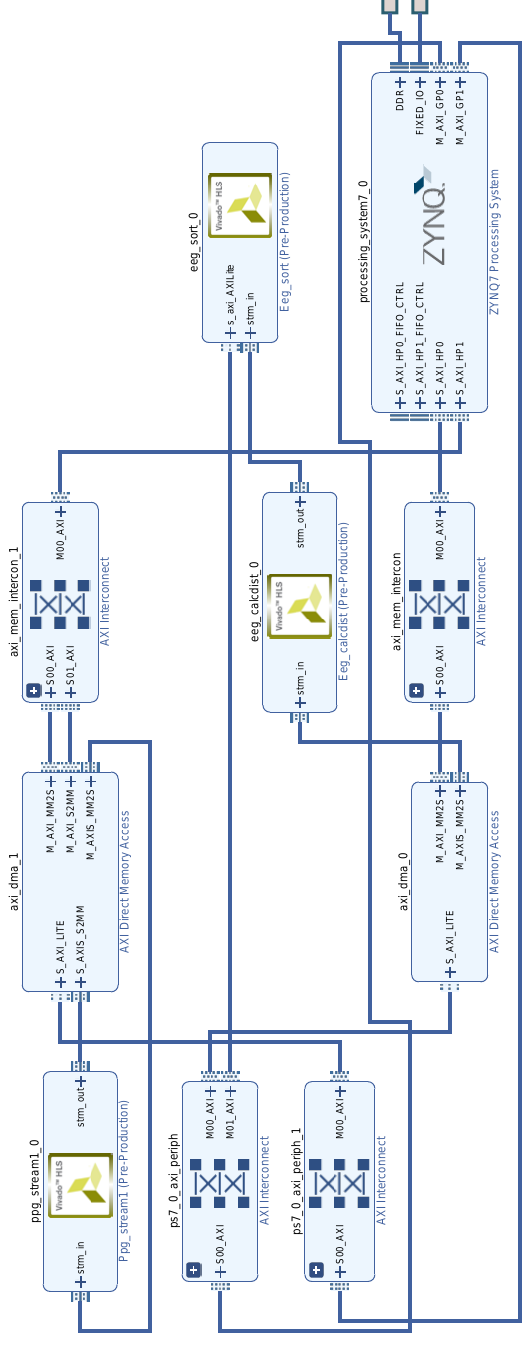
Figure 9. Block diagram representing the integration of the biometric system, obtained in Vivado